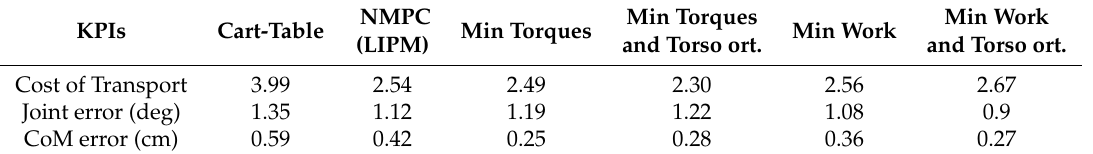
Table 4. [Hardware experiment result.] Key Performance Indicators (KPIs) for the starting step. KPIs Cart-Table